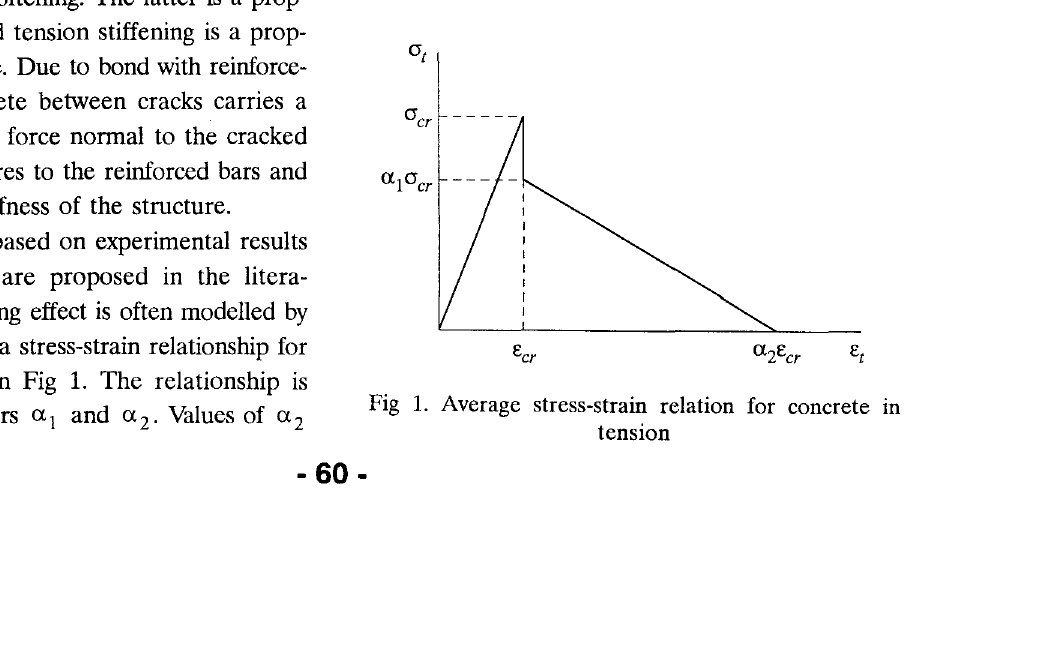
Fig 1. Average stress-strain relation for concrete in